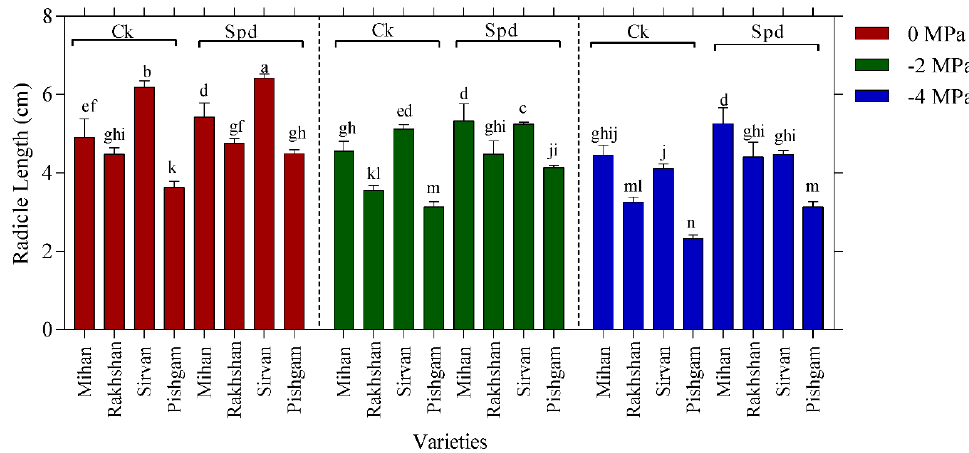
Figure 1. Effect of spermidine (Spd) on radicle length of four wheat varieties under drought stress with three levels of PEG 6000 osmotic potential (−2, −4 Mpa and 0 using distilled water as control). Ck = distilled water. Different letters indicate statistically significant differences across all three levels of PEG 6000 at p < 0.05 level using LSD’s test. Analysis of variance showed that there were significant interactions between drought stress and varieties ( p ≤ 0.01), varieties and Spd ( p ≤ 0.05) on radicle weight of four wheat varieties, too (Table 1). According to these results, the highest mean radicle weight